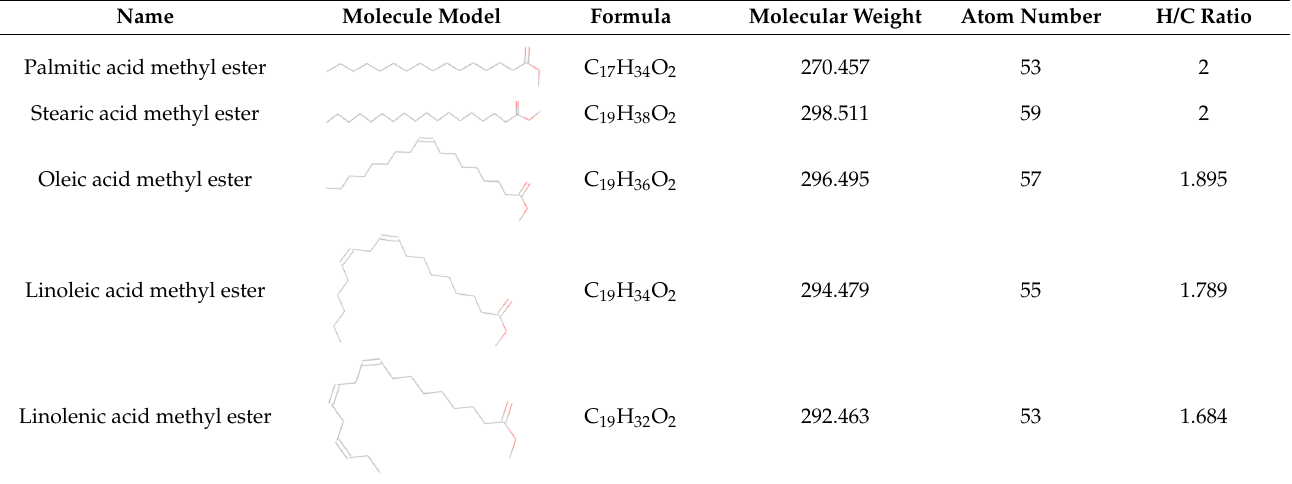
C18:3 Linolenic acid methyl ester C18:3 Linolenic acid methyl ester Figure 1. Molecular structure of each component in biodiesel (carbon: grey, hydrogen: white, oxy- gen: red). 3.2. Simulation Procedure The molecular dynamics method was used to investigate the interaction between as- phaltene and biodiesel at the molecule level, and all the simulation calculations were per- formed using Materials Studio (version 8.0). The Condensed-phase Optimized Molecular Potentials for Atomistic Simulation Studies (COMPASS) force field is ideal for this study since the research subjects are organic molecules. COMPASS force field, which includes bonded potential and non-bonded potential, is one of the most frequently used force fields in the petroleum industry. It can forecast the structural, vibrational, and thermophysical characteristics of a wide variety of organic and inorganic compounds, such as asphaltene and biodiesel, with great accuracy [42]. Figure 1. Molecular structure of each component in biodiesel (carbon: grey, hydrogen: white, oxy- gen: red). 3.2. Simulation Procedure The molecular dynamics method was used to investigate the interaction between as- phaltene and biodiesel at the molecule level, and all the simulation calculations were per- formed using Materials Studio (version 8.0). The Condensed-phase Optimized Molecular Potentials for Atomistic Simulation Studies (COMPASS) force field is ideal for this study since the research subjects are organic molecules. COMPASS force field, which includes bonded potential and non-bonded potential, is one of the most frequently used force fields in the petroleum industry. It can forecast the structural, vibrational, and thermophysical characteristics of a wide variety of organic and inorganic compounds, such as asphaltene and biodiesel, with great accuracy [42]. Figure 1. Molecular structure of each component in biodiesel (carbon: grey, hydrogen: white, oxy- gen: red). 3.2. Simulation Procedure The molecular dynamics method was used to investigate the interaction between as- phaltene and biodiesel at the molecule level, and all the simulation calculations were per- formed using Materials Studio (version 8.0). The Condensed-phase Optimized Molecular Potentials for Atomistic Simulation Studies (COMPASS) force field is ideal for this study since the research subjects are organic molecules. COMPASS force field, which includes bonded potential and non-bonded potential, is one of the most frequently used force fields in the petroleum industry. It can forecast the structural, vibrational, and thermophysical characteristics of a wide variety of organic and inorganic compounds, such as asphaltene and biodiesel, with great accuracy [42]. Figure 1. Molecular structure of each component in biodiesel (carbon: grey, hydrogen: white, oxy- gen: red). 3.2. Simulation Procedure The molecular dynamics method was used to investigate the interaction between as- phaltene and biodiesel at the molecule level, and all the simulation calculations were per- formed using Materials Studio (version 8.0). The Condensed-phase Optimized Molecular Potentials for Atomistic Simulation Studies (COMPASS) force field is ideal for this study since the research subjects are organic molecules. COMPASS force field, which includes bonded potential and non-bonded potential, is one of the most frequently used force fields in the petroleum industry. It can forecast the structural, vibrational, and thermophysical characteristics of a wide variety of organic and inorganic compounds, such as asphaltene and biodiesel, with great accuracy